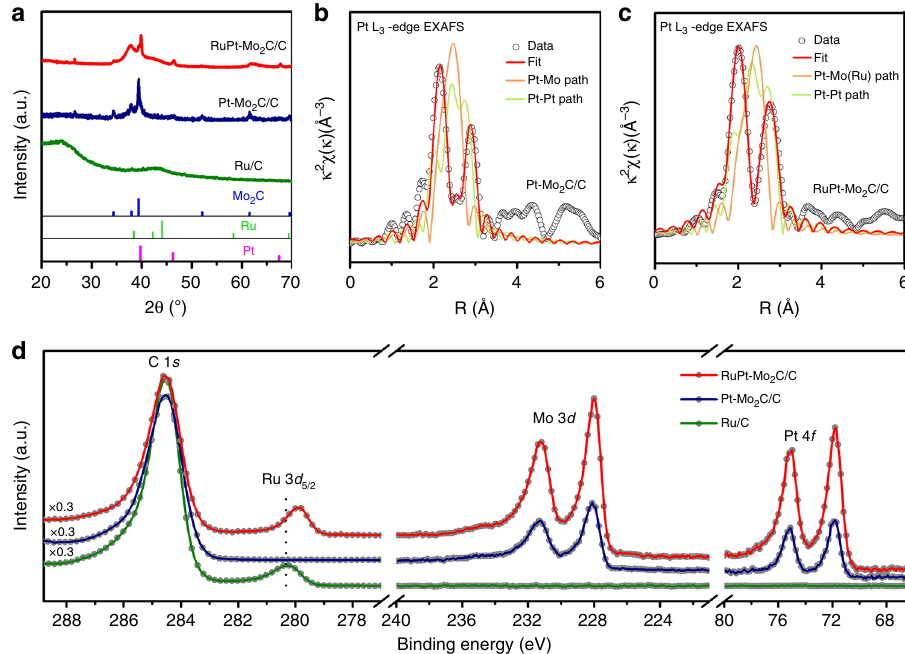
Fig. 2 XRD, EXAFS and XPS analyses of different catalysts. a XRD patterns of the different catalysts; b , c Pt L 3 -edge EXAFS pro fi les and fi ts of fresh catalysts: b for the Pt-Mo 2 C/C and c for the RuPt-Mo 2 C/C; d XPS spectra of different catalysts